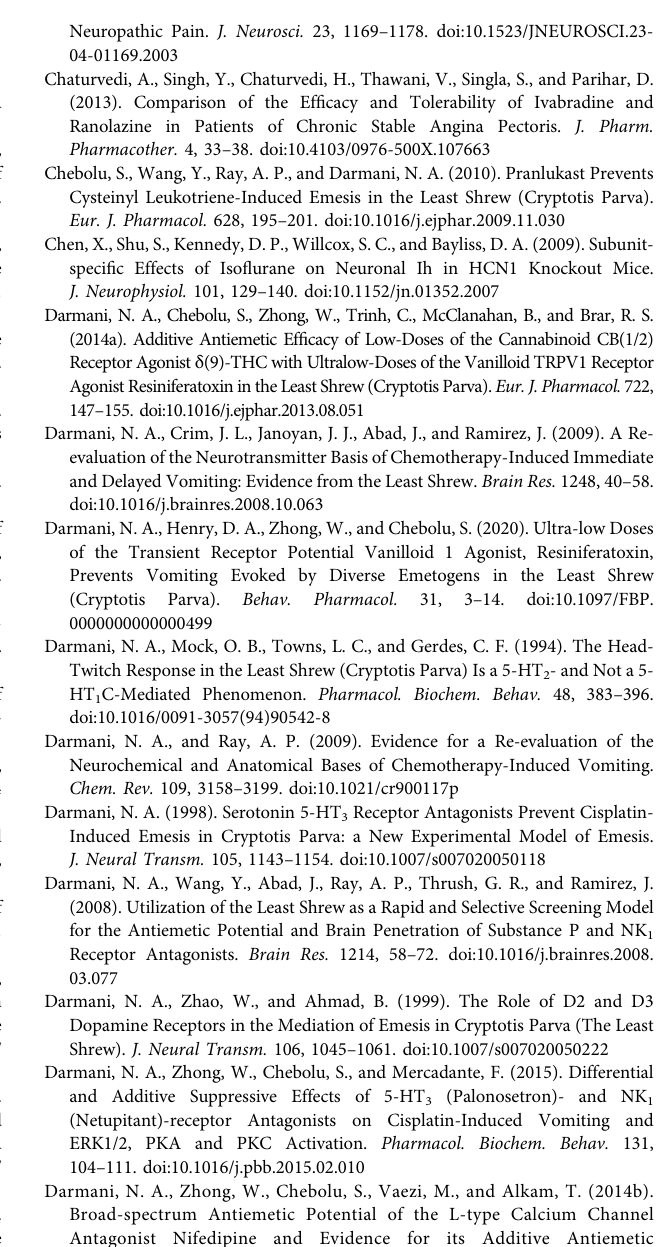
Supplemental Figure 1 | Quanti fi ed data for ZD7288-induced c-Fos expression in TPH2 positive cells in the least shrew brainstem dorsal vagal complex, containing the area postrema (AP), the nucleus tractus solitarius (NTS) and the dorsal motor nucleus of the vagus (DMNX). Values represent the mean number of c-Fos expressing and TPH2 positive cells in each region of interest per section and are presented as mean ± SEM (n (cid:2) 3 shrews per group). ** p < 0.01, *** p < 0.001 vs. Control (treated with vehicle of ZD7288), Unpaired